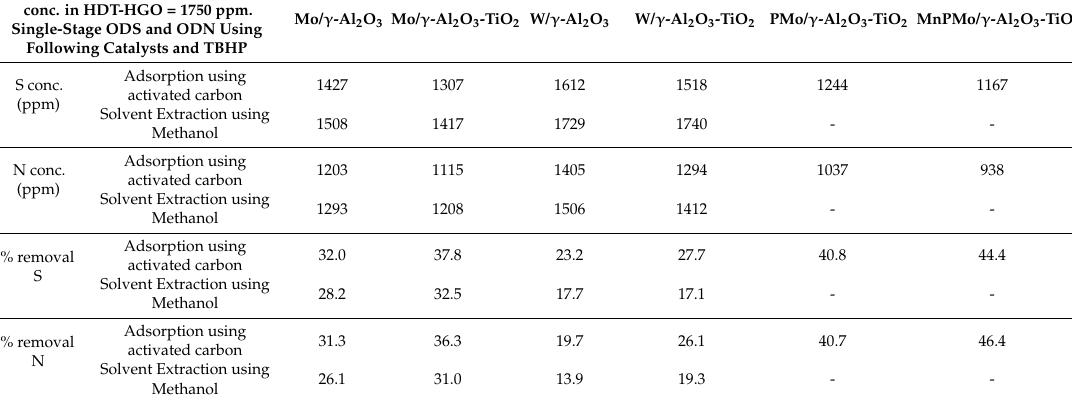
Table 3. Oxidative desulfurization and denitrogenation of hydrotreated heavy gas oil. (error ± 4 ppm). S conc. in HDT-HGO = 2100 ppm. N conc. in HDT-HGO = 1750 ppm. Single-Stage ODS and ODN Using Following Catalysts and